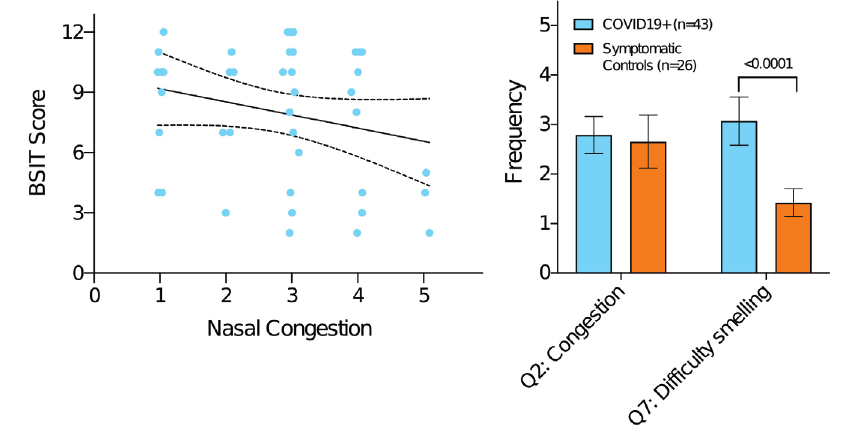
Figure 4. BSIT Scores do not correlate with congestion COVID-19 patients suggesting a congestion independent mechanism of OD. A) There was no significant correlation between BSIT scores in COVID-19 patients and self-reported nasal congestion (r=-0.233, p=0.13). The simple linear regression (solid line) is plotted with 95% confidence interval bands (dotted lines), (slope = -0.638, 95% CI –1.48 to 0.203). Simulated noise was performed to display overlapping points. B) There was no significant difference between self-reported congestion in COVID-19 patients vs symptomatic controls (0.137, p=0.66). COVID-19 patients had self-reported increased difficulty smelling (-1.65, p<0.001). Error bars represent 95% confidence intervals. The